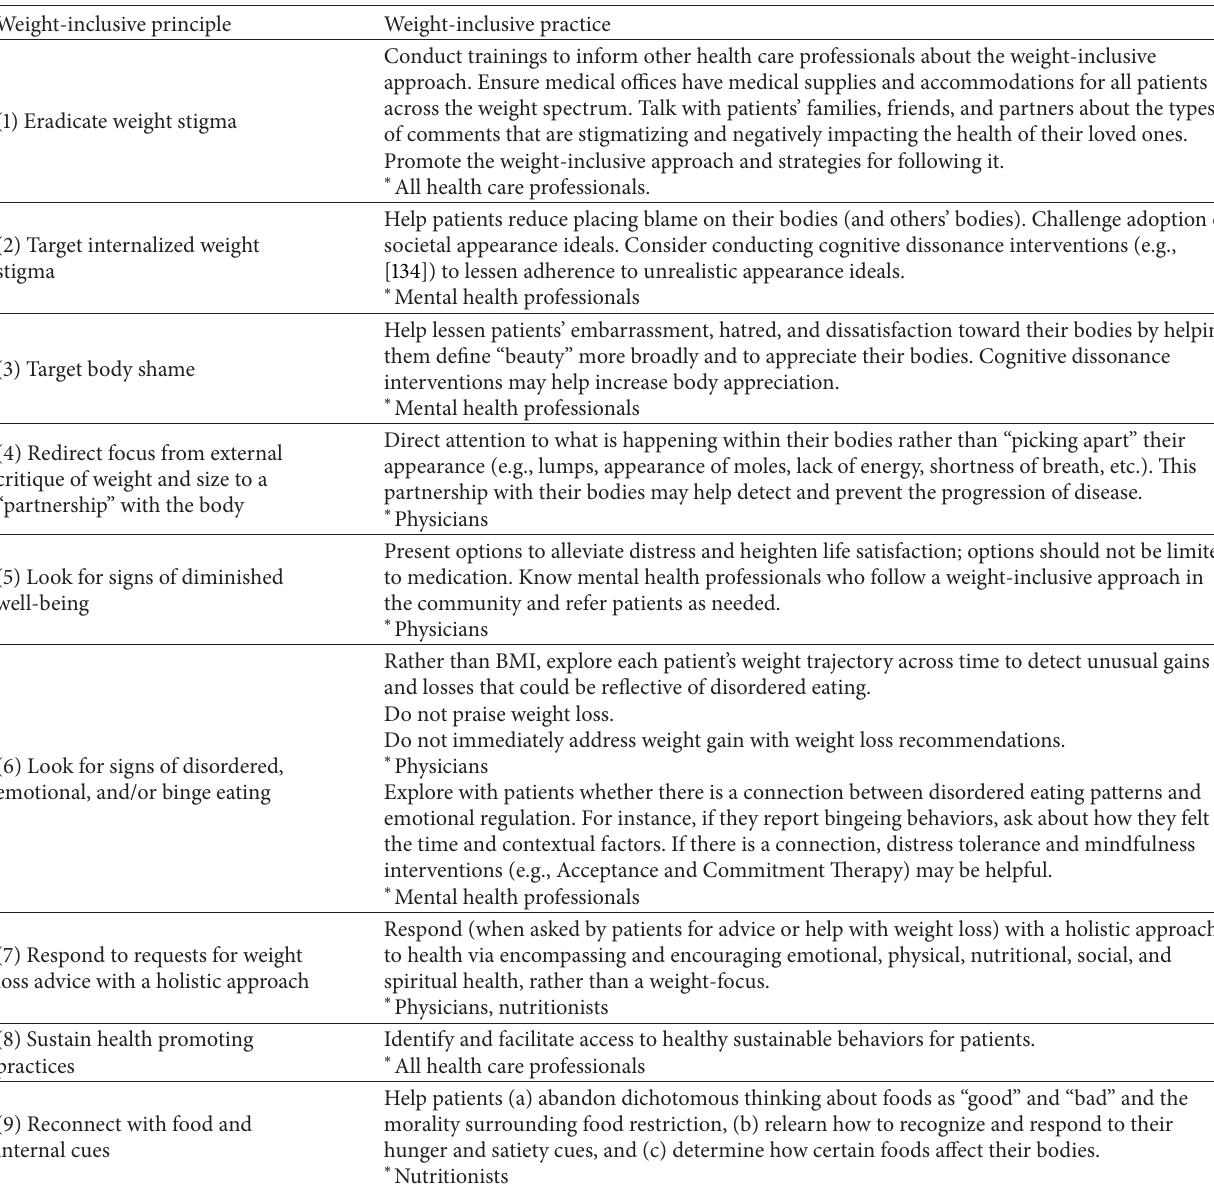
Table 1: Translating weight-inclusive principles into weight-inclusive